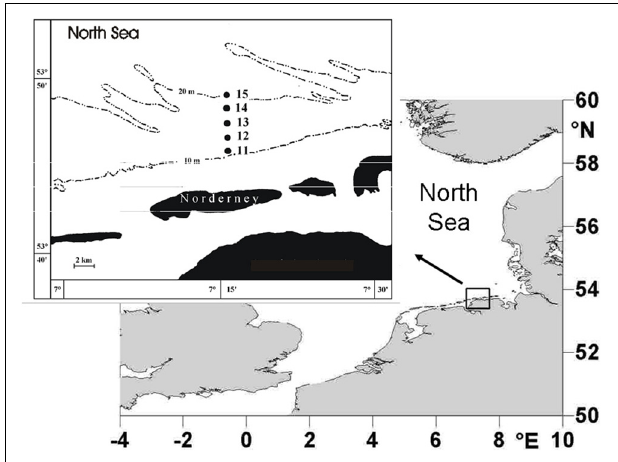
FIGURE 1 | Study area off the island of Norderney in the southern North Sea, showing the stations sampled from 1978 to 2012 (modified after Kröncke et al.,